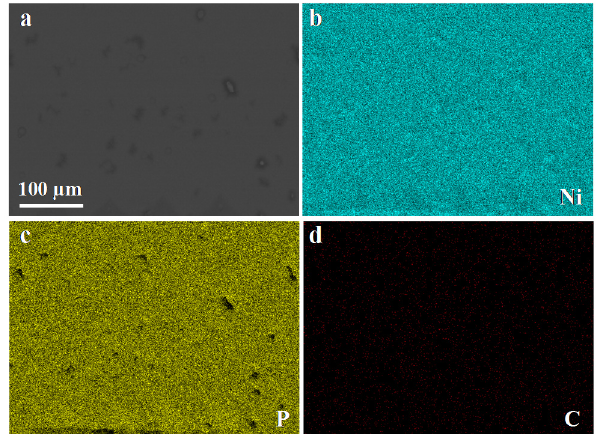
Figure 6. Ni ‐ P coating obtained on the SG cast iron after 60 min at T = 84 °C. ( a ) SEM top ‐ view observation (BSE detector); ( b ) nickel EDX mapping analysis (K α = 7.47 eV); ( c ) phosphorus EDX mapping analysis (K α = 2.01 eV); and ( d ) carbon EDX mapping analysis (K α = 0.27 eV).